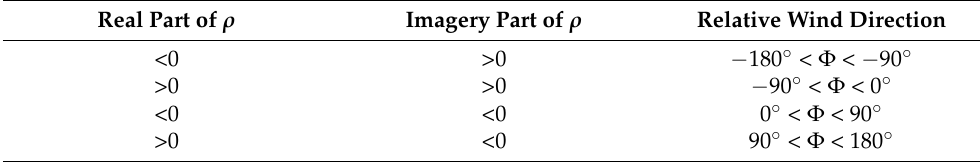
Table 4. Discriminant rule from polarization correlation coefficient to wind direction. Real Part of ρ Imagery Part of ρ Relative Wind Direction